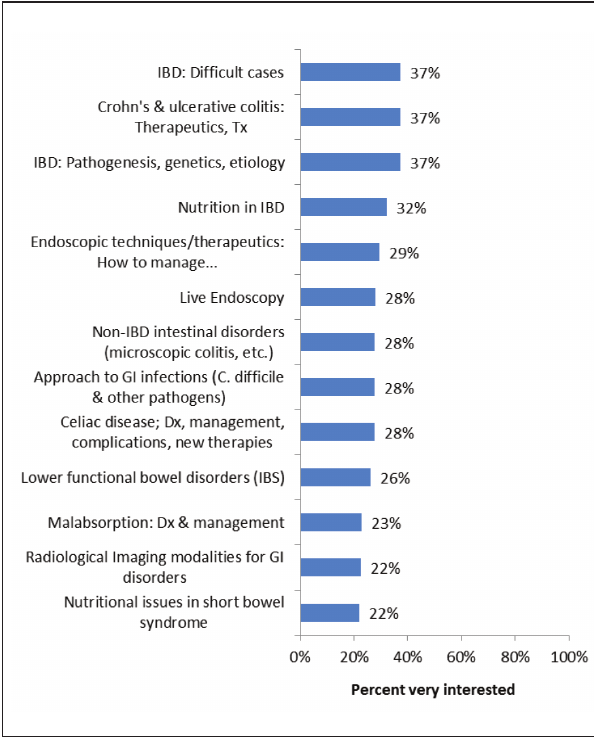
Figure 1) The 13 most popular topics for educational events based on the percent of respondents who were ‘very interested’ in the area. C difficile Clostridium difficile ; Crohn’s Crohn disease; Dx Diagnosis; GI Gastrointestinal; IBD Inflammatory bowel disease; IBS Irritable bowel